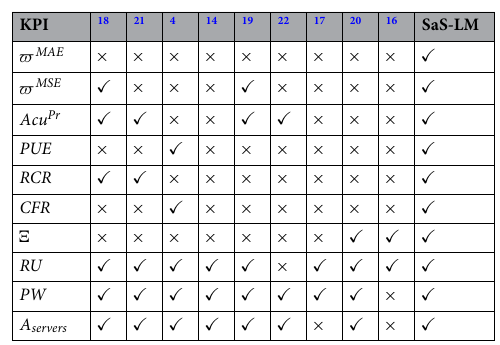
MAE : mean absolute prediction error, ̟